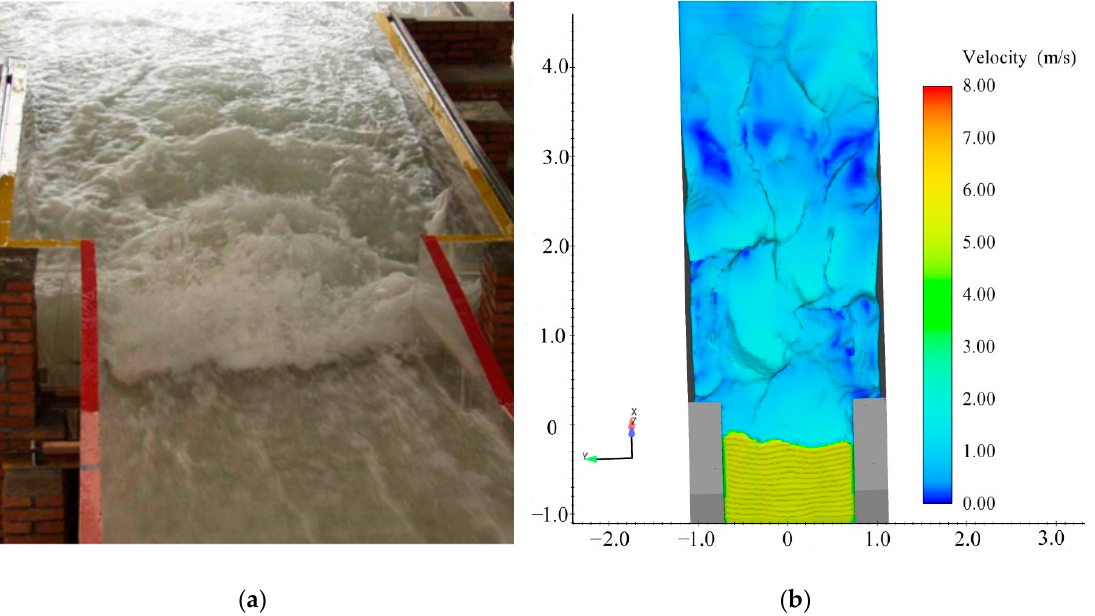
Figure 5. Flow pattern of operating condition 1: ( a ) Physical model flow diagram; ( b ) Simulation model flow.